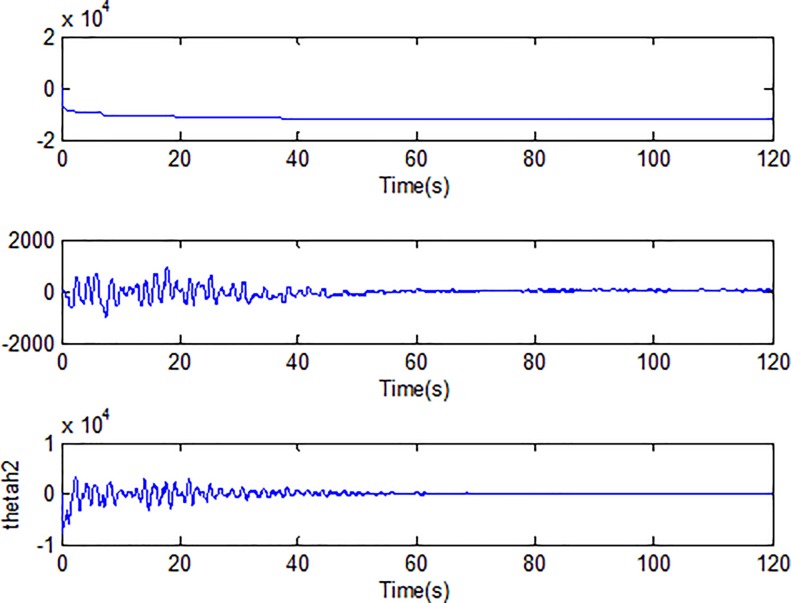
Adaption of θh along Y axis.